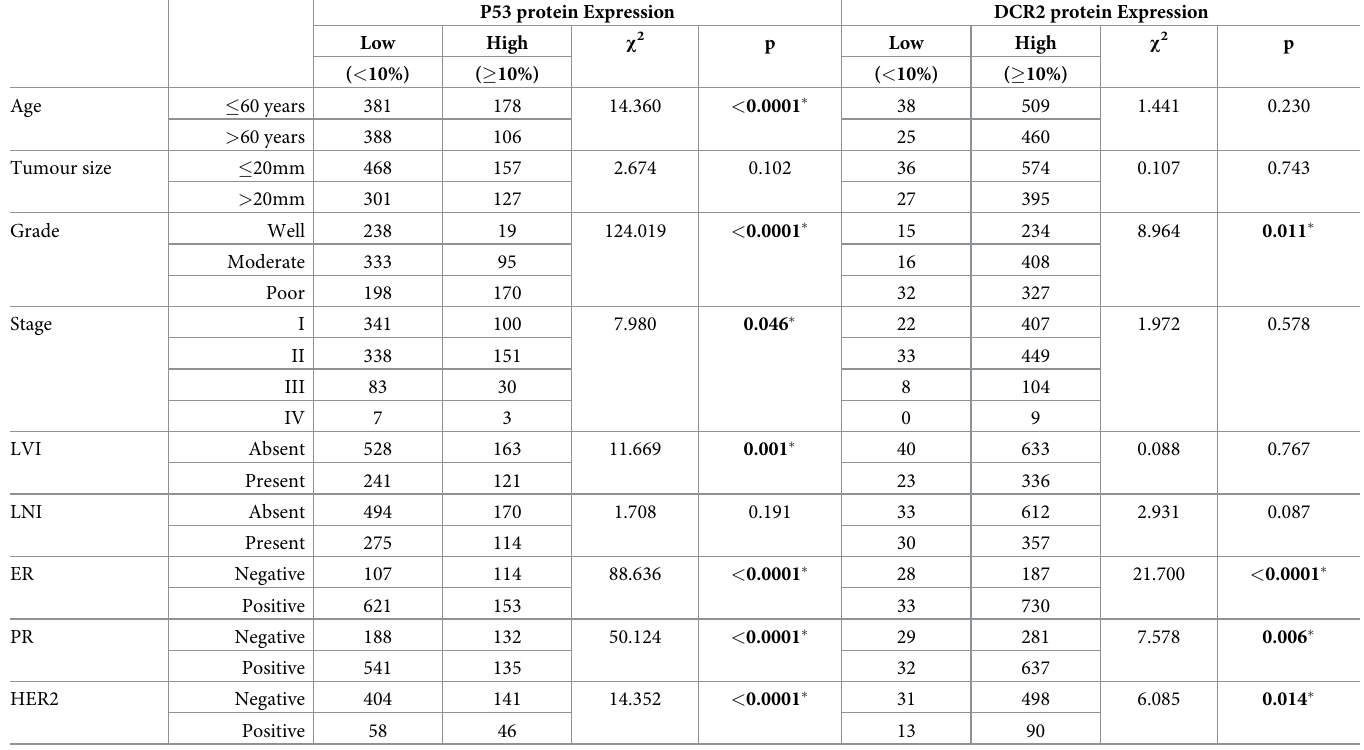
Table 2. Association of senescence-associated markers with clinicopathological